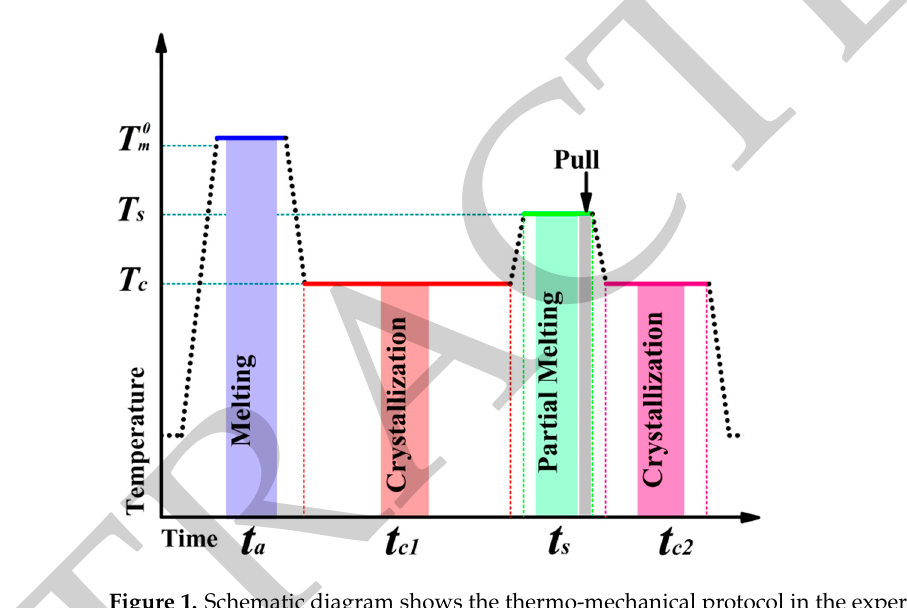
Figure 1. Schematic diagram shows the thermo-mechanical protocol in the experiment.